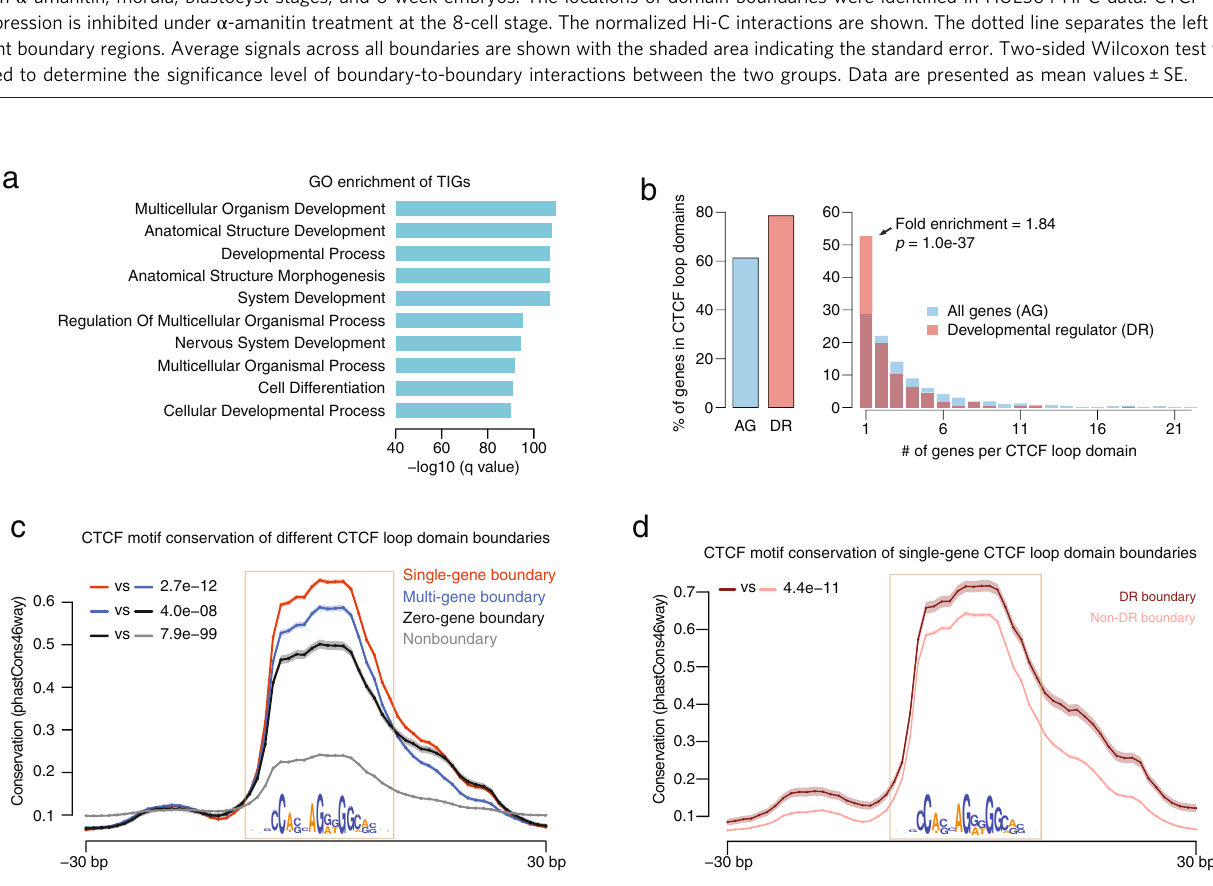
Fig. 3 Topological insulation of developmental regulators. a Gene Ontology (GO) enrichment of TIGs in HUES64 shows developmental processes as top terms. b Enrichment of developmental regulators in single-gene CTCF loop domains. The left panel represents the percentage of all genes (AG) or developmental regulators (DR) located within domains. The right panel represents the percentage of AG or DR located within domains containing an increasing number of protein-coding genes. P -values calculated by two-sided Fisher ’ s exact test. c Evolutionary conservation of consensus CTCF motifs at boundaries of single-gene, multi-gene, and zero-gene CTCF loop domains and nonboundaries. Nonboundary CTCF motifs represent the motifs that are outside of any domain boundaries. The motif region is shown in the box and the motif sequence is displayed. The average conservation score across placental mammals across all boundary regions is shown. The shaded area indicates the standard error. Two-sided Wilcoxon test p -value tested in the motif regions is shown. Data are presented as mean values± SE. d Evolutionary conservation of consensus CTCF motifs at DR boundaries and non-DR boundaries. See more descriptions in c . Data are presented as mean values ± looping due to boundary perturbation (Fig. 4d, e), we concluded that there was a decreased frequency of enhancer-gene contacts during de fi nitive endoderm formation between the SOX17 promoter and its tissue-speci fi c enhancer DRE (A)) in the SOX17 Δ 5 ’ CTCF#8.2 cell line (Fig. 4f). SOX17 is known to be a key early endoderm transcription factor 33,34 and is frequently used to identify embryonic